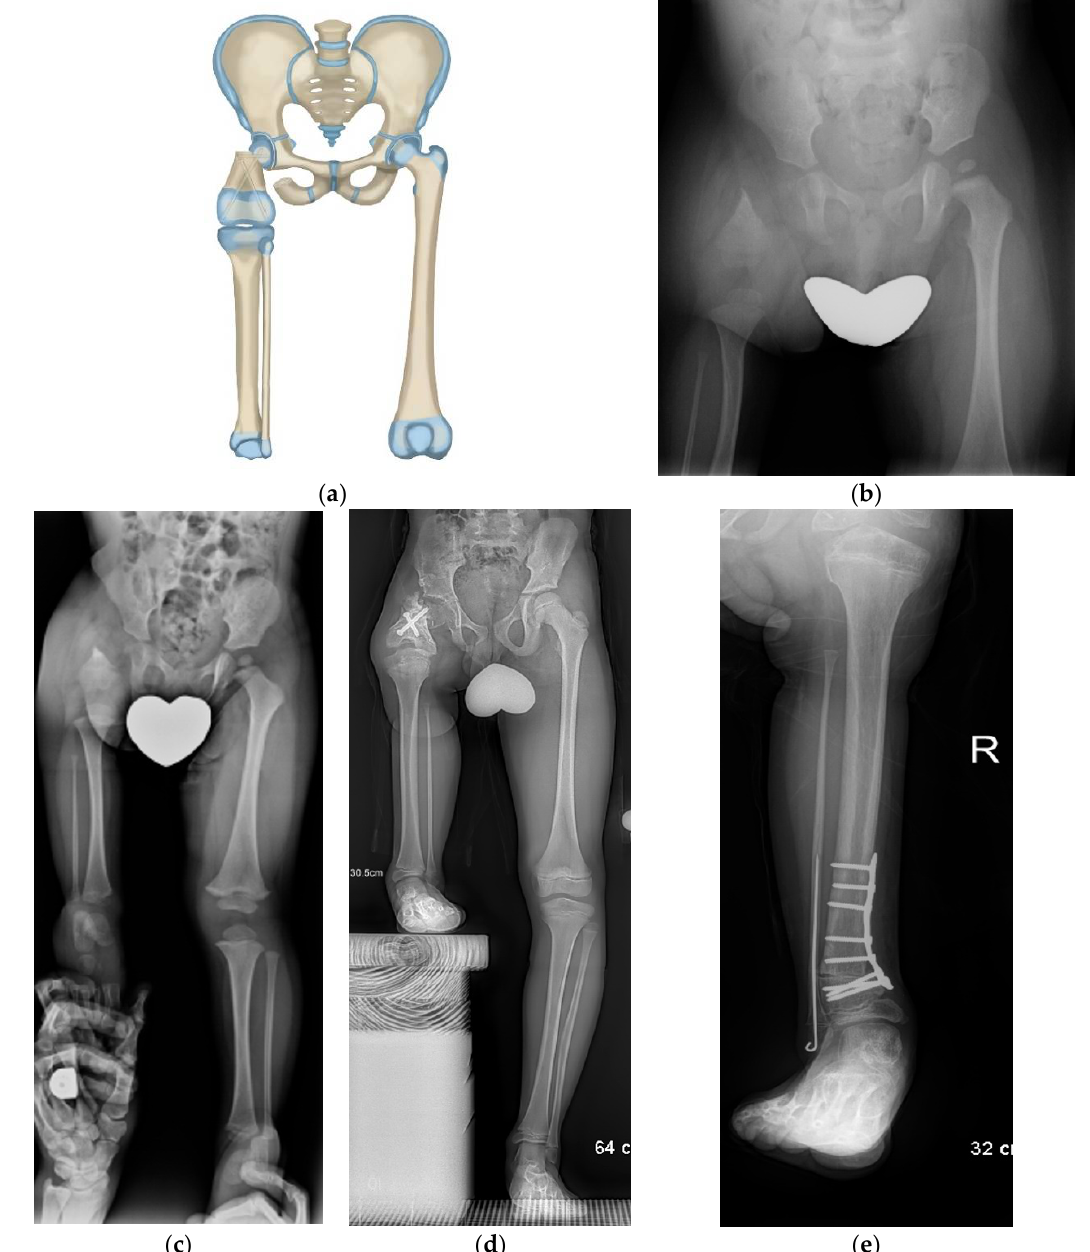
Figure 4. ( a ) Paley rotationplasty illustration. ( b ) AP pelvis of 2-year-old boy with CFD Paley type 3a. ( c ) Standing radiographs in same boy before surgery showing ankle is at level of opposite knee. ( d ) Since the femoral head was mobile a Paley rotationplasty was performed. Standing long radiograph in same boy, 8 years after Paley rotationplasty. ( e ) To improve his prosthetic fitting he had a varus derotation surpramalleolar osteotomy performed 8 years after the original rotationplasty. Clinically he is very sports active and has excellent gait and